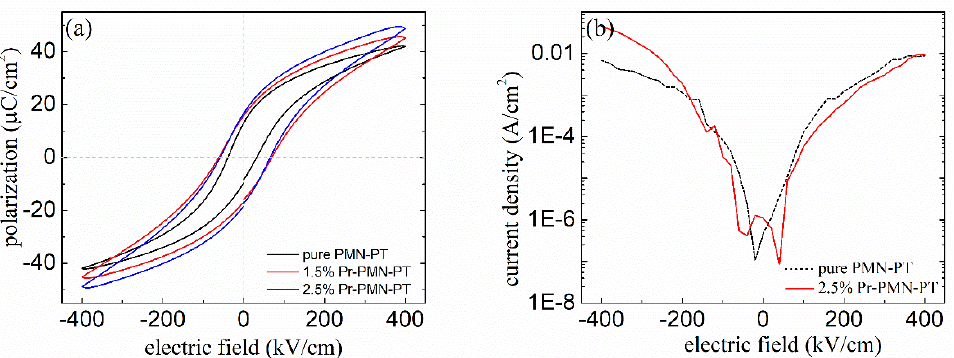
Figure 4. ( a ) P-E hysteresis loops for pure PMN-PT and Pr-PMN-PT thin films annealed at 650 °C for 2 min, ( b ) leakage current density dependent on external electric field for pure PMN-PT and 2.5% Pr-PMN-PT thin films.